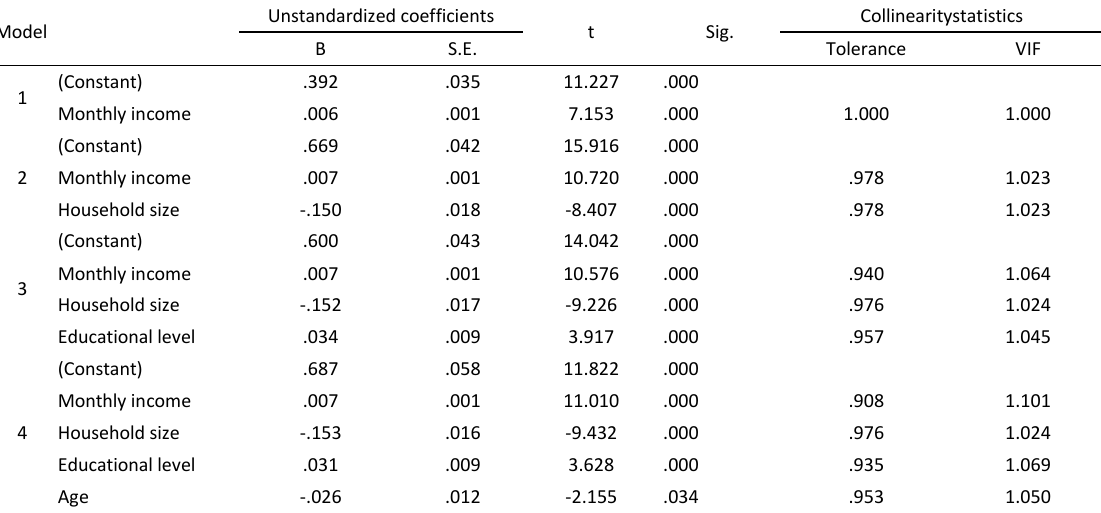
Table 6: Estimated regression coefficient of independent variables